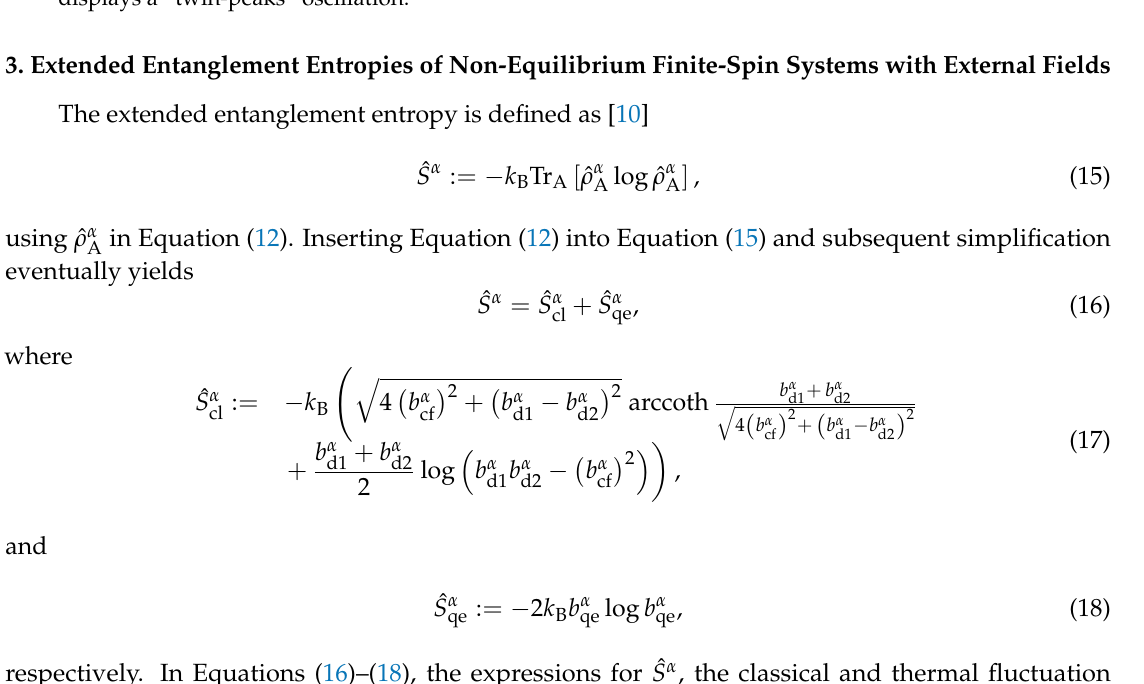
Figure 2. Time dependence of the matrix elements, b c and non-dissipative systems with K − 1 = ( β J ) − 1 = 0.7 and h = β g µ B H = 3/7 for the competing cases. Parts ( a – c ) show cases with a scaled dissipation rate of e / ω = 1, 0.1, and 0.01, respectively. The dot-dot-dashed lines ( - respectively. In part ( d ), the non-dissipation case ( e = 0), b c displays a “twin-peaks” oscillation.